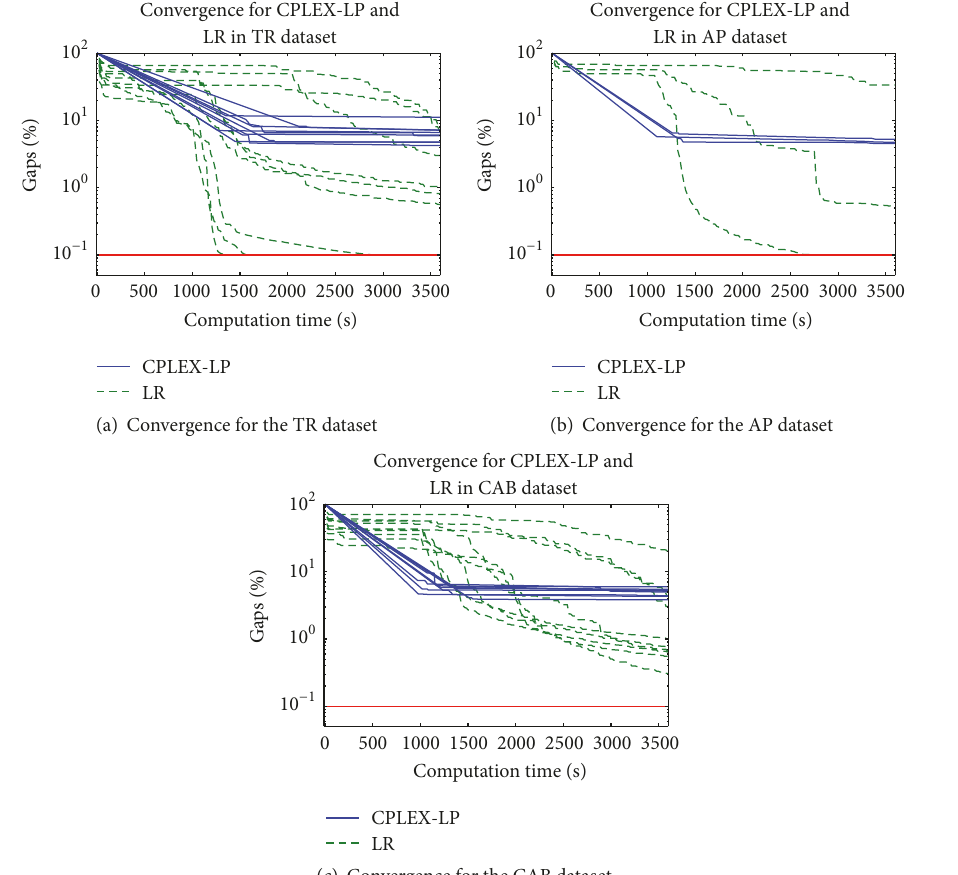
Figure 6: Convergence of CPLEX-LP and LR for RMA problems with 𝑛 = 25 , 𝑝 ∈ {3, 5,7} , and 𝛼 ∈ {0.3, 0.5, 0.7} for the TR dataset and CAB dataset as well as 𝛼 = 0.75 for the AP dataset: LR converges gradually, whereas the gaps of CPLEX-LP stay almost stable after around 1,500